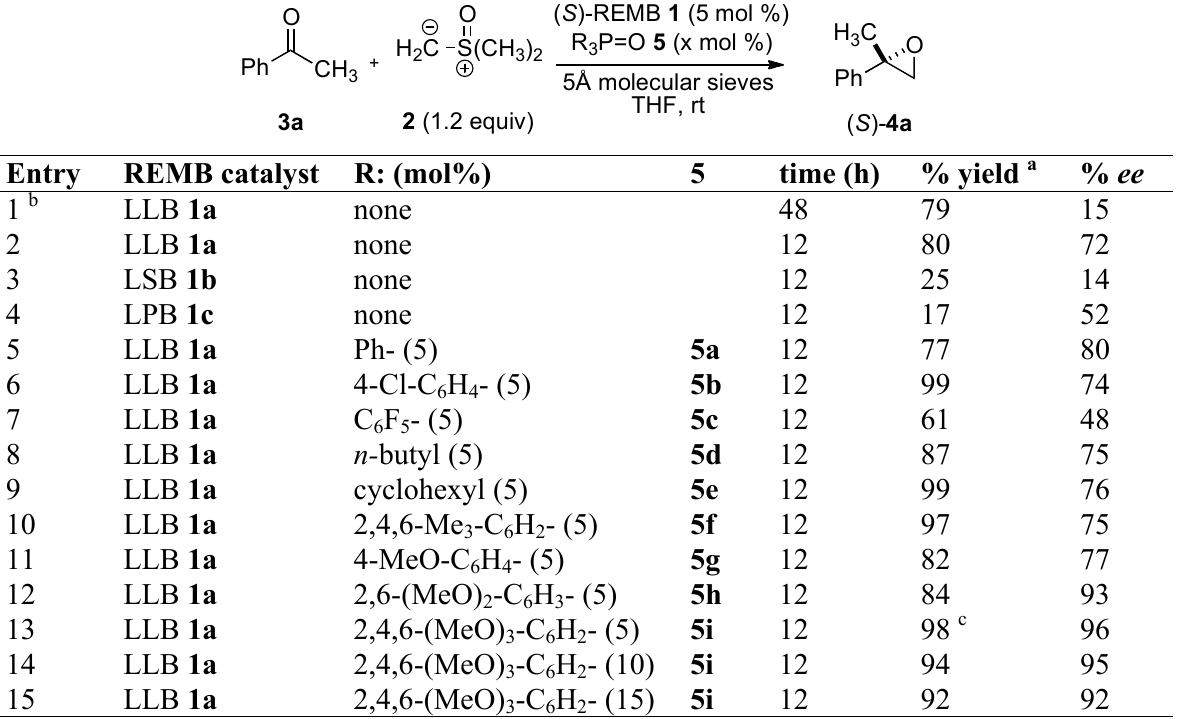
Table 1. Optimization of reaction